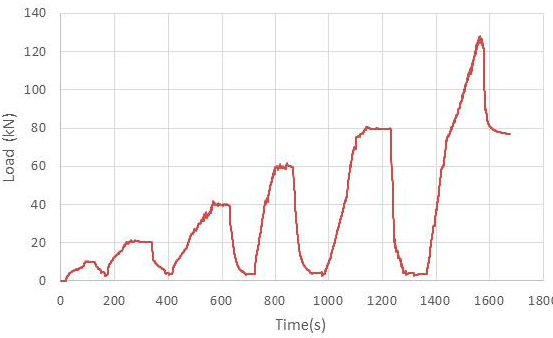
Figure 5. Typical load history of a diagonal tension test. Appl. Sci. 2018 , 8 , 98